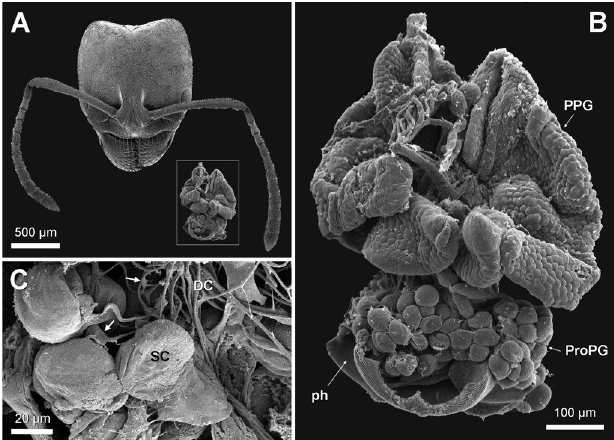
Fig 1 . Scanning electron micrographs of the pharyngeal glands of Brachyponera sennaarensis workers. A . Frontal view of the head with dissected pharyngeal glands (enlarged in B) shown at the same magnification. B . Ventral view of pharynx (ph) with attached pro- (ProPG) and postpharyngeal glands (PPG). C . Detail of secretory cells (SC) and slender duct cells (DC) of propharyngeal gland. Arrows indicate local widening of duct cells in region where duct cell nucleus occurs.